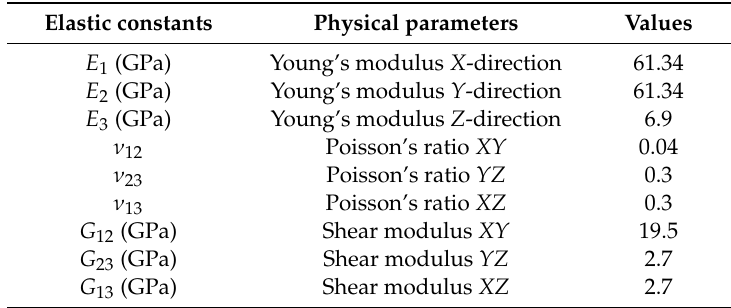
Table 1. Key parameters of T300 woven prepreg.